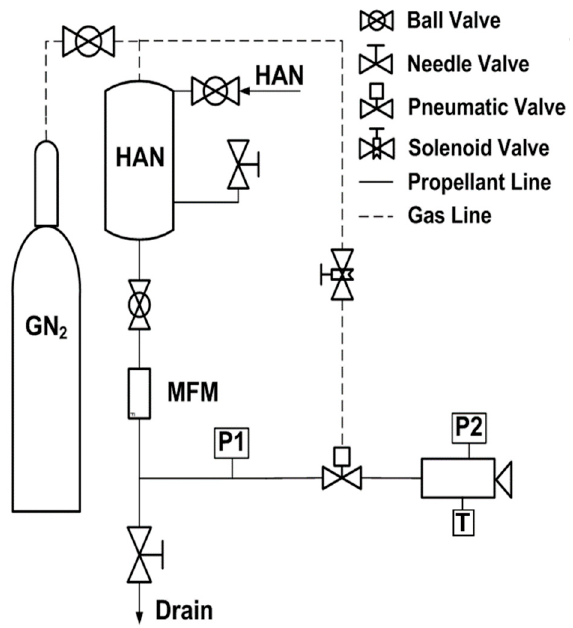
Figure 6. Schematic of the experimental setup.